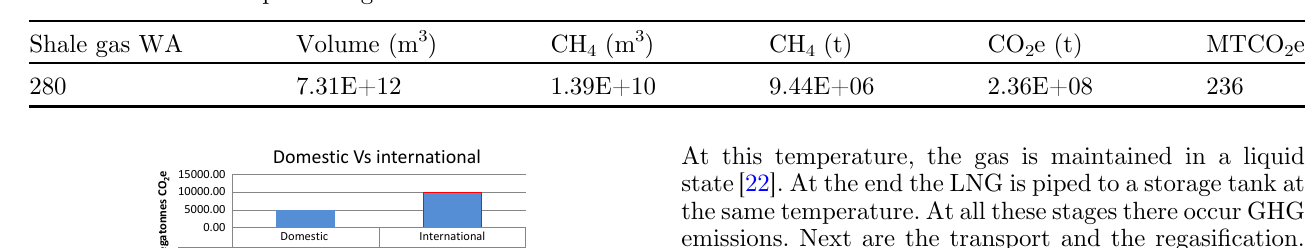
Table 6. Estimated processing loss